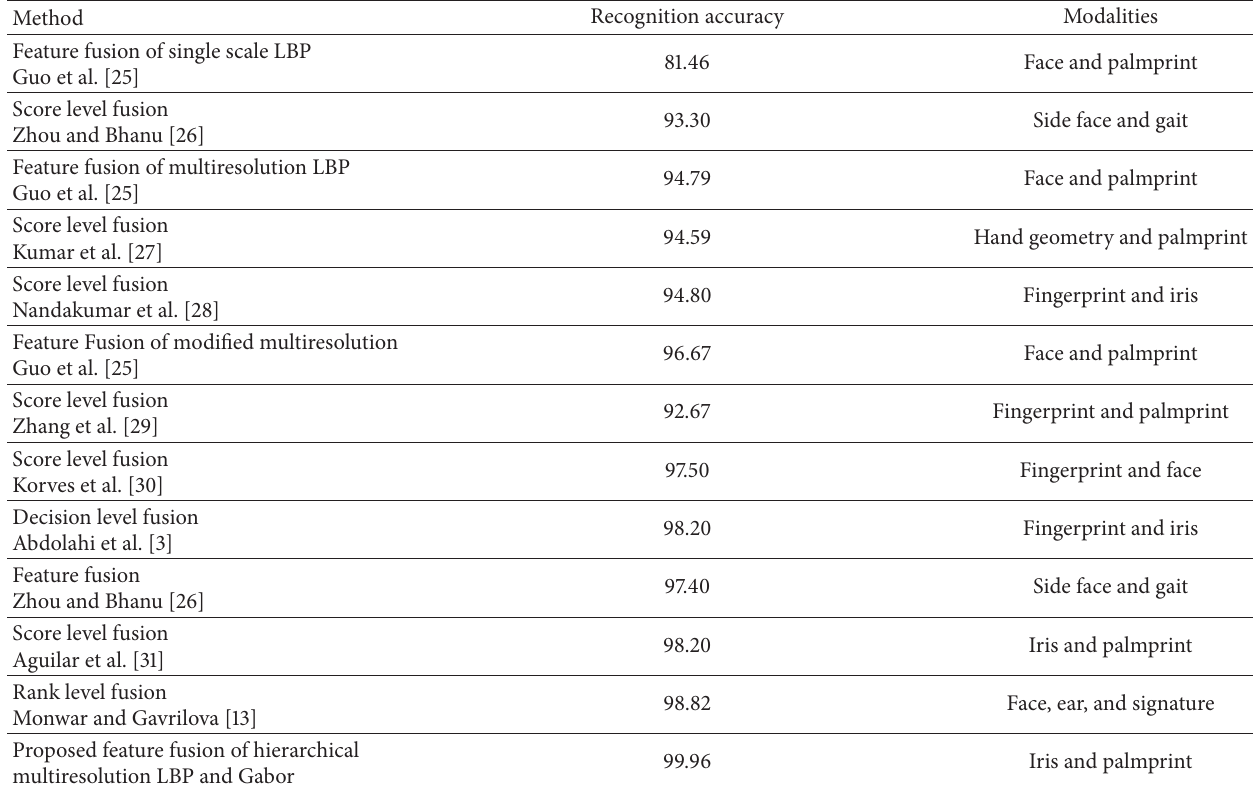
Table 5: Comparison of various